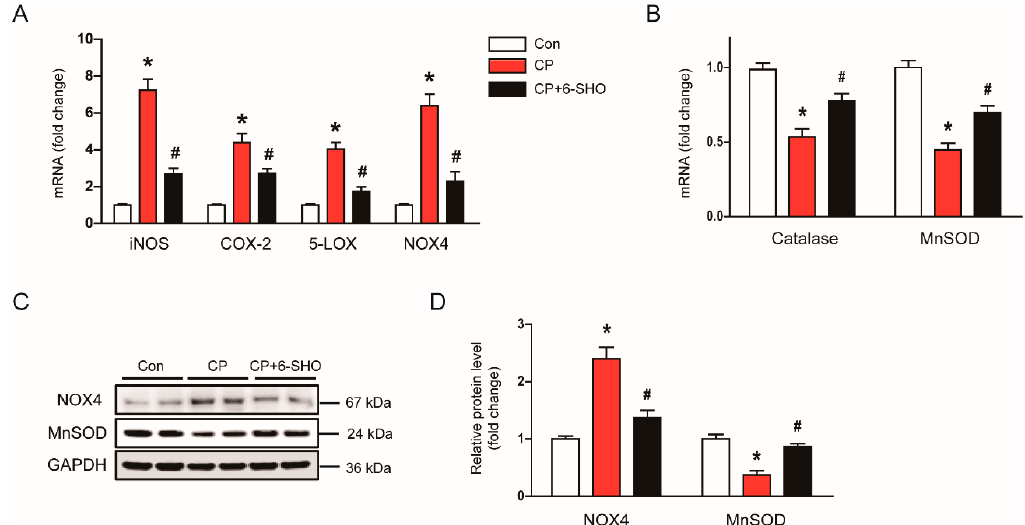
Figure 5. Effect of 6-shogaol on expression of prooxidant and antioxidant enzymes in cisplatin-treated mice. ( A ) Relative mRNA levels of inducible nitric oxide synthase (iNOS), cyclooxygenase-2 (COX-2), 5-lipoxygenase (5-LOX), and nicoti- namide adenine dinucleotide phosphate oxidase 4 (NOX4). ( B ) Relative mRNA levels of catalase and manganese superoxide dismutase (MnSOD). ( C ) Western blotting of NOX4 and MnSOD. ( D ) Quantification of western blots for NOX4 and MnSOD. Glyceraldehyde-3-phosphate dehydrogenase (GAPDH) was chosen as an internal control. n = 8 per group of mice. * p < 0.05 versus Con. # p < 0.05 versus CP.